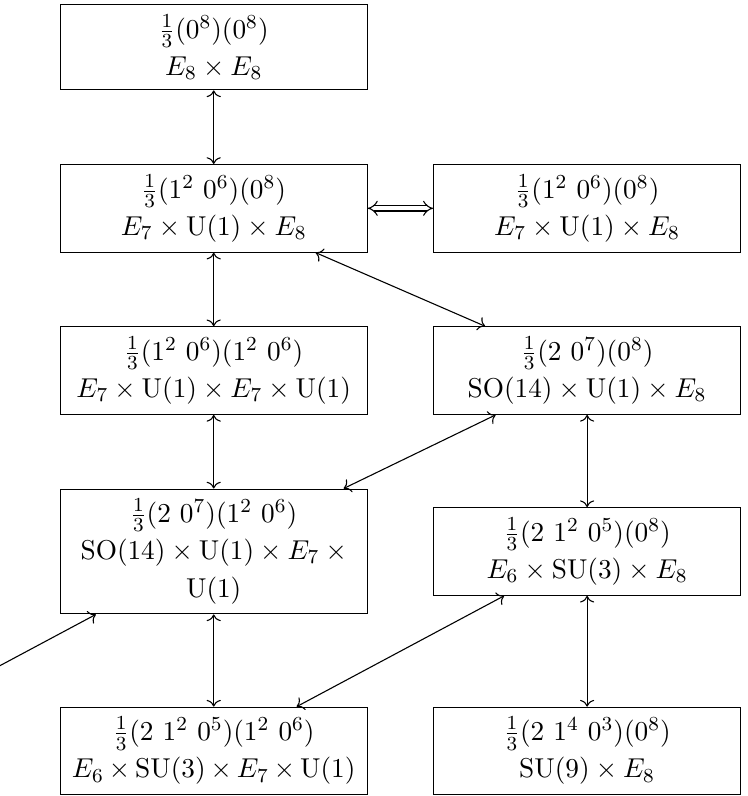
respectively shift vectors V the same zero point energy correction (cid:1) E